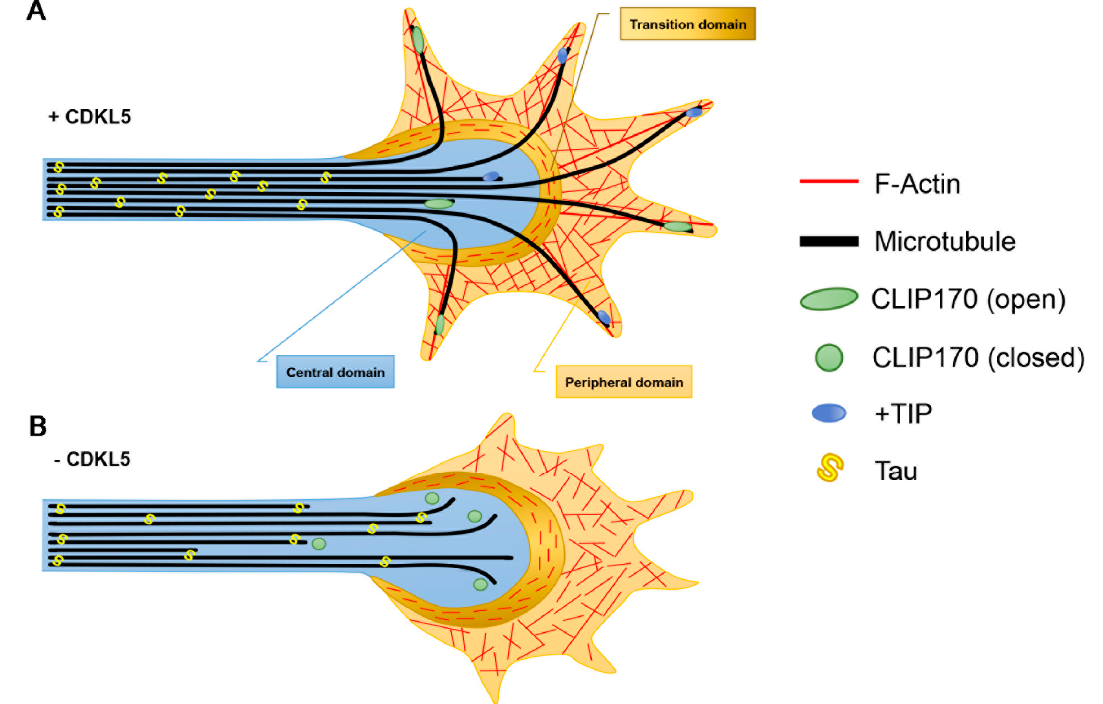
Figure 2. The effect of CDKL5 deficiency on microtubule dynamics in axonal growth cones. ( A ) In the axon, microtubules (MTs) are organised in a polar fashion with the plus-ends oriented distally. The central domain, which is contiguous with the axonal shaft, is rich in MTs that are bound by plus-end tracking proteins (+TIPS) including CLIP170. The peripheral domain is rich in actin that extends into the filopodia. The transition zone, lying in between these two domains, contains antiparallel actin arcs that form a barrier against the invasion of MTs into the peripheral domain. ( B ) In the absence of CDKL5, CLIP170 is in its closed conformation and is less associated with the MT plus-ends impacting their capacity to engorge into the actin rich area and leading to cessation of axonal outgrowth.